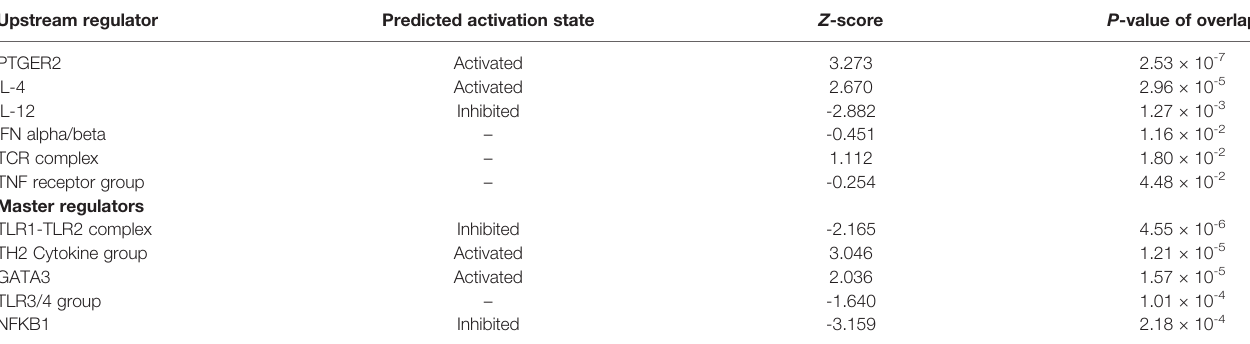
TABLE 3 | Selection of signi fi cant upstream and master regulators. Upstream